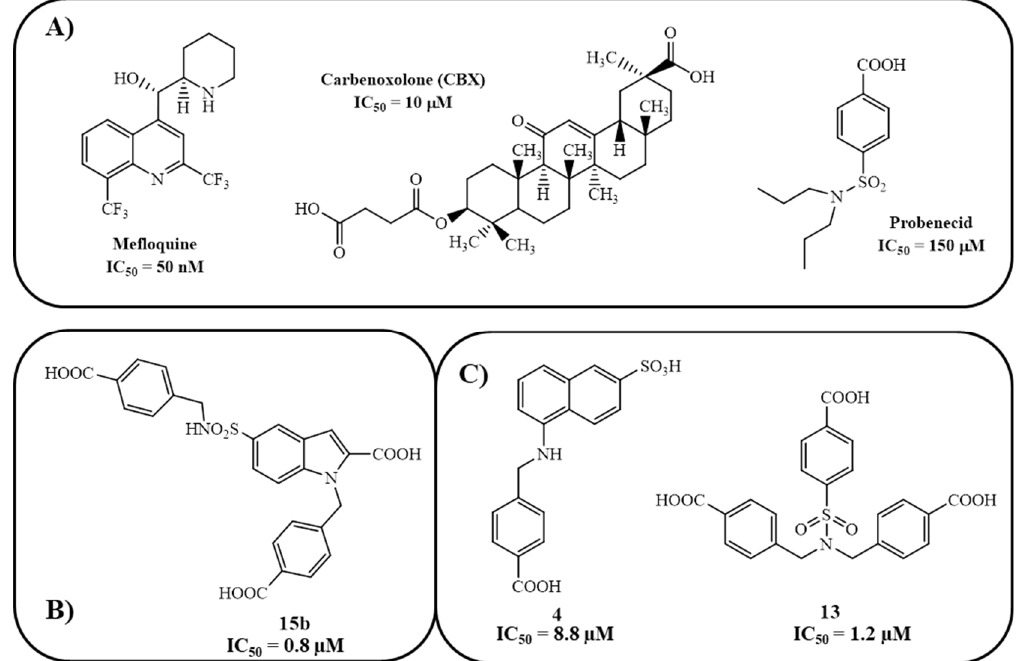
Figure 1. Panx-1 blockers of the literature (panel ( A )); new Panx-1 blockers recently published by us (panels ( B , C )) (numbering is that of the original manuscript).